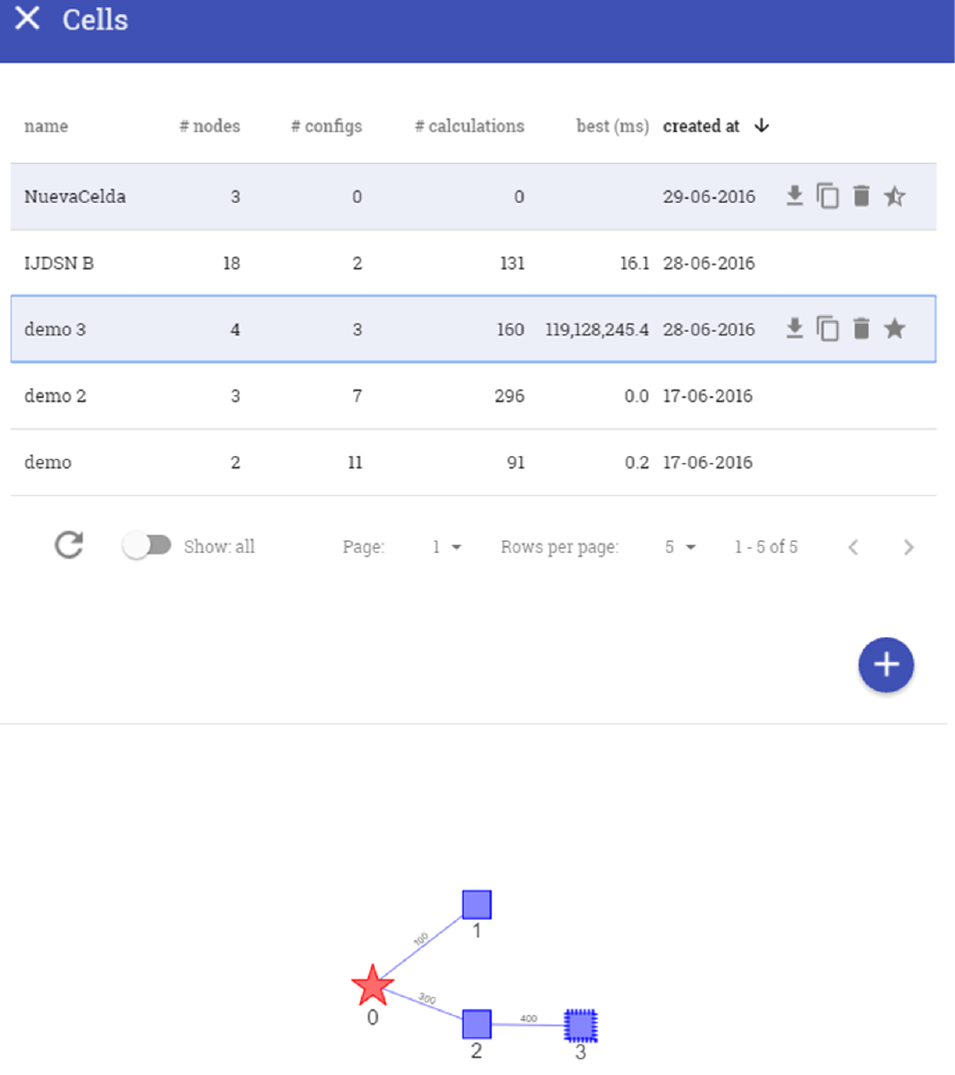
Figure 11. Results display detail.